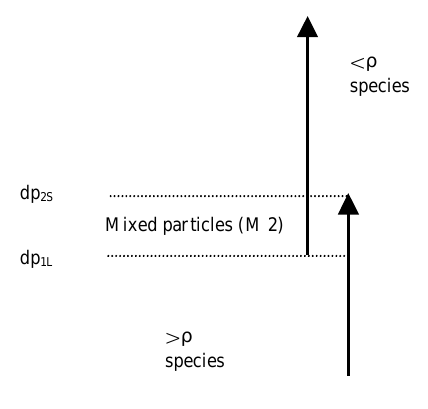
is the identical system to 4a , experiencing increased grav-